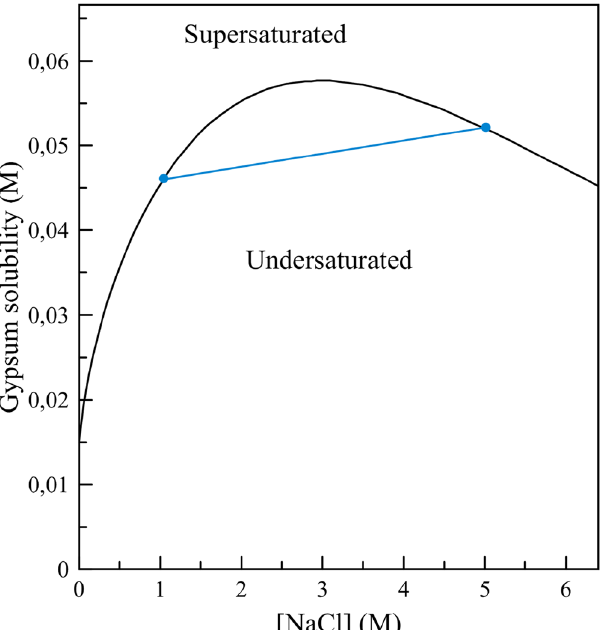
Figure 4. Solubility of gypsum as a function of NaCl concentration (calculated using the PHREEQC code and the Pitzer database). The compositions indicated by the two blue dots are those used in the experiment with synthetic solutions. The blue line represents the compositions obtained by mixing two brines equilibrated with